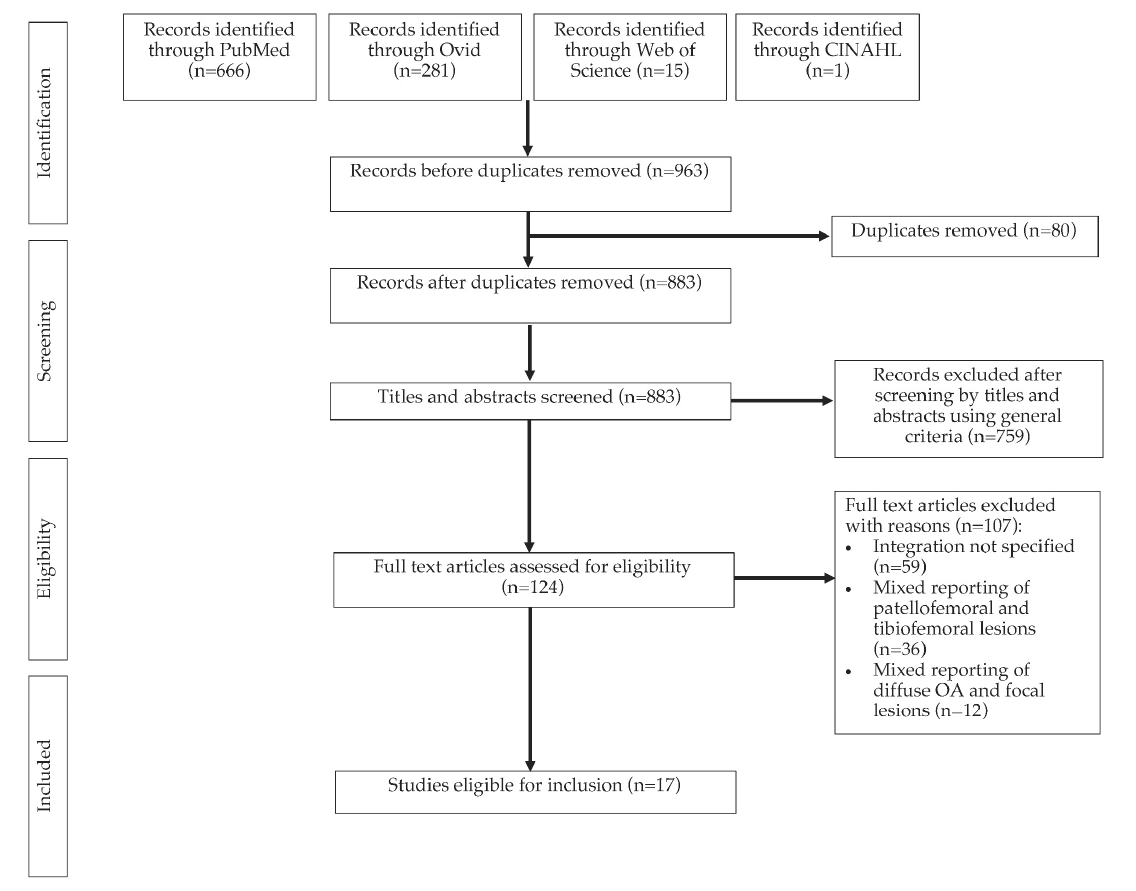
Figure 1. A PRISMA diagram of the study selection process.